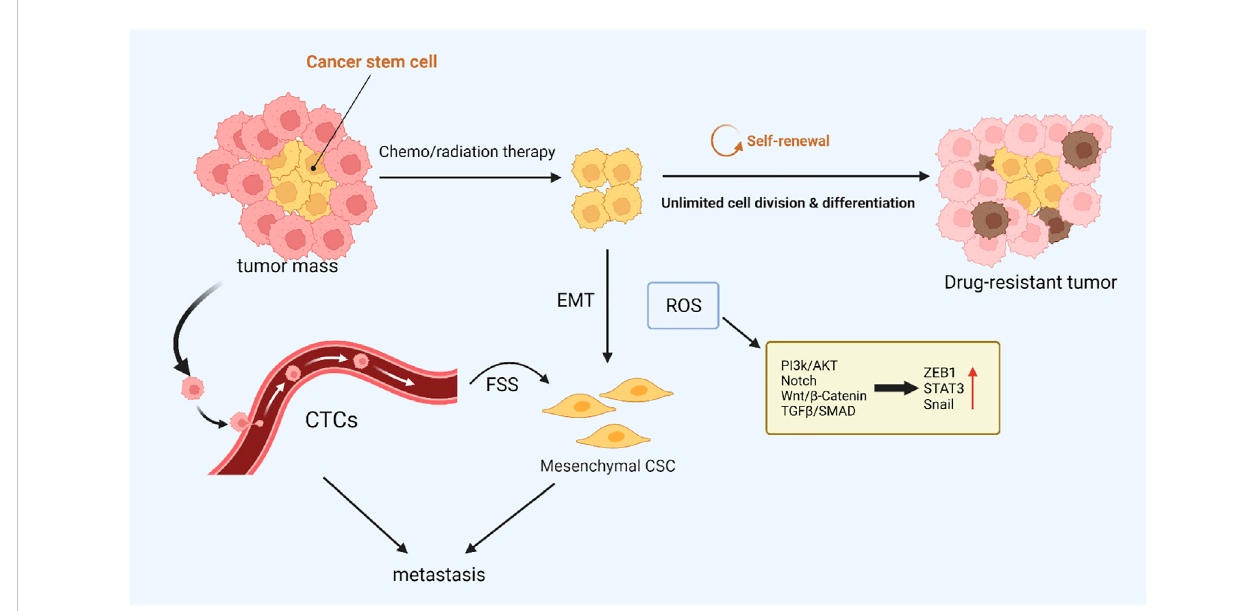
FIGURE 3 ROS-mediatedcancercellstemness.CSCswithlowintracellularROSlevelsareresistanttochemo-orradiotherapy,andCTCsarecloselyrelatedto tumormetastasis.TheseresistantCSCsmaycontributetolocalrecurrenceormetastasis via EMT.ROScandrivebothEMTandstemcellphenotypes,and the activated signaling pathways are